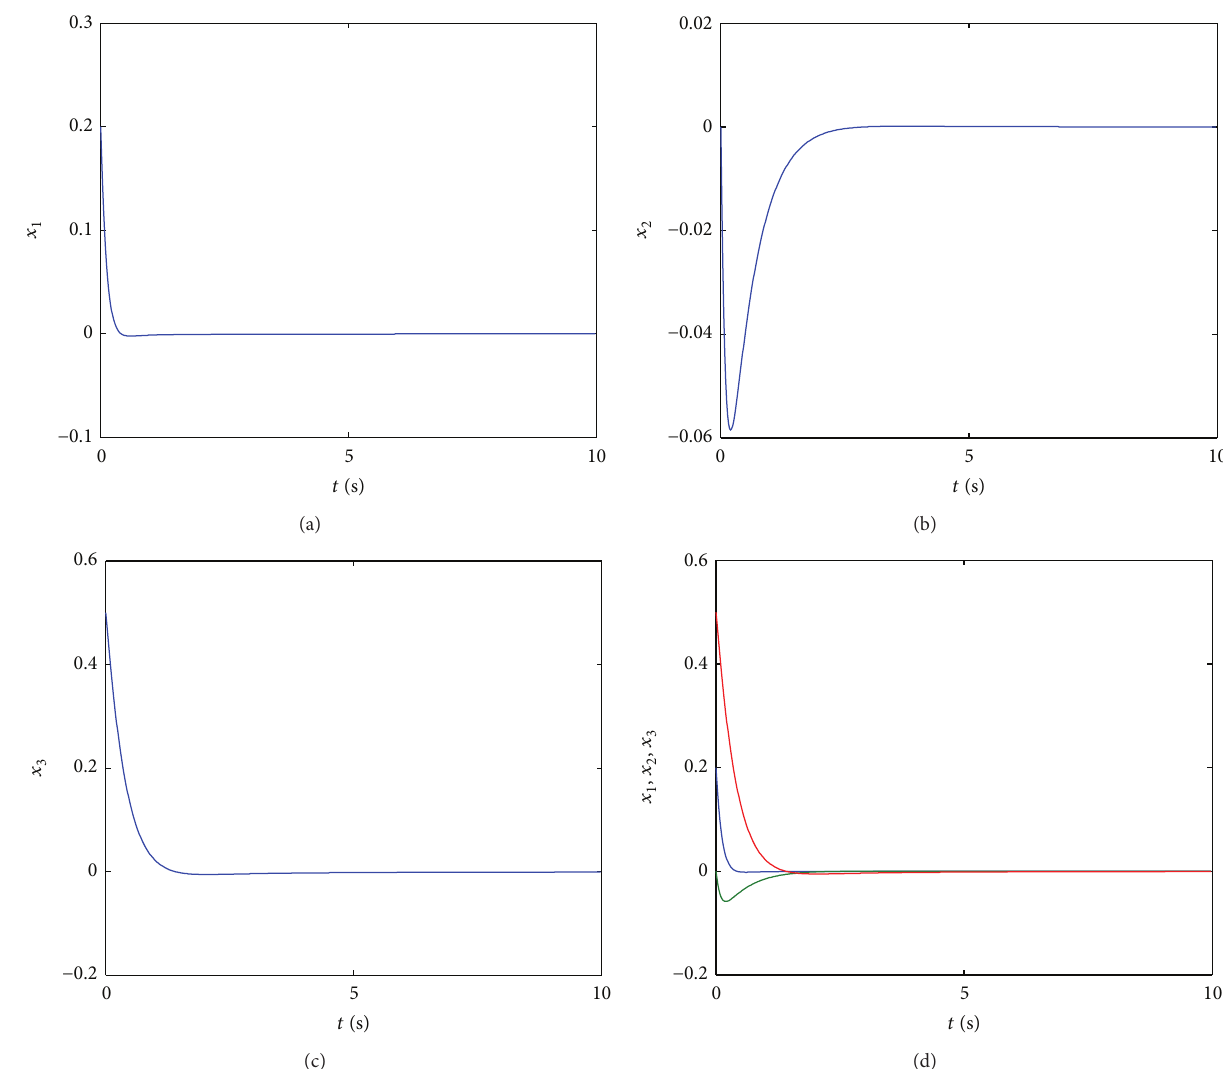
Figure 8: Time waveforms of state variables 𝑥 1 (𝑎) , 𝑥 2 (𝑏) , and 𝑥 3 (𝑐) of the controlled fractional order Liu system.